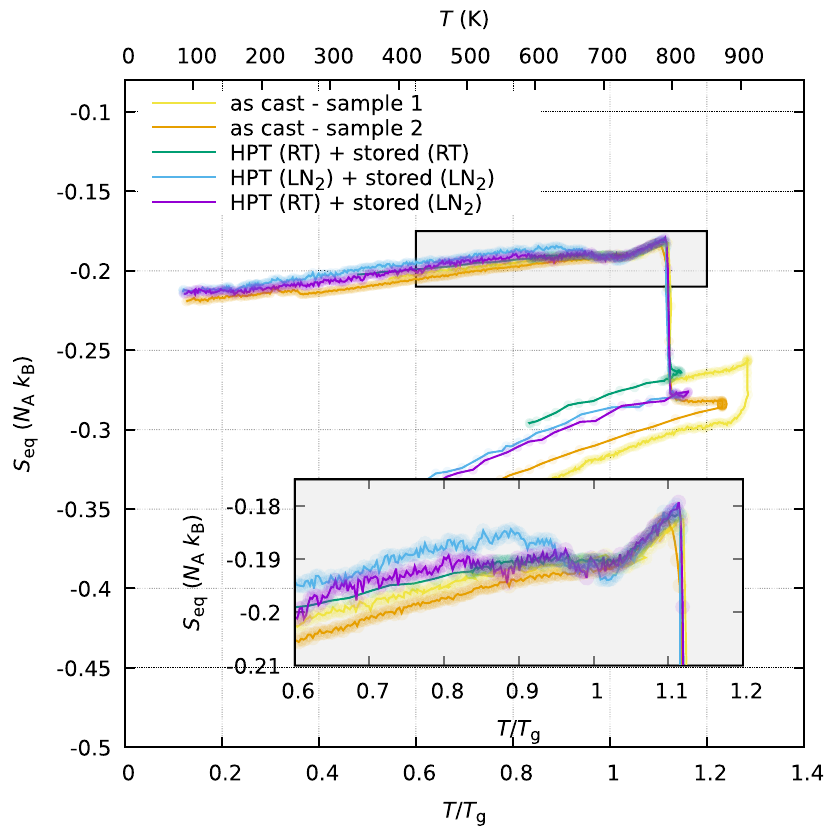
Fig. 2 Change in equivalent con fi gurational entropy as determined by Eq. (2). Each point is derived from a reduced PDF calculated from an X-ray diffraction pattern. The curves have been shifted by an additive constant on the ordinate axis ( S eq -axis) in order to assure overlapping in the liquid state (unshifted data in Supplementary Fig. 1). The lower x axis is normalized to the glass transition temperature T g = 709